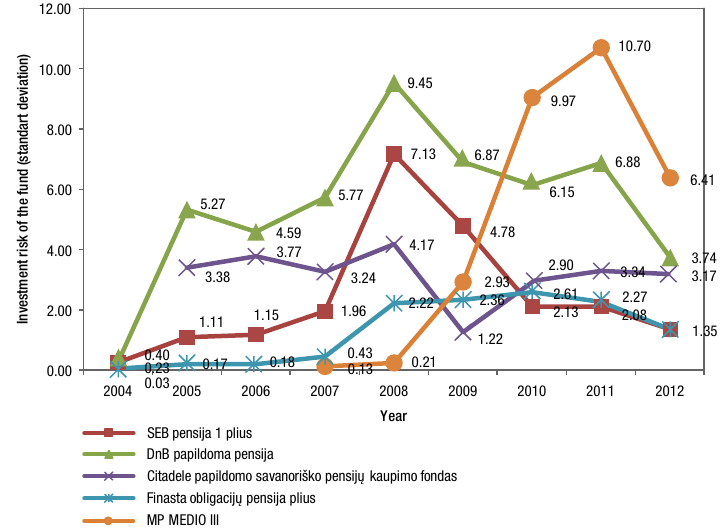
Fig. 5. Change of bond and balanced 3 rd pillar PF standard deviation during 2004–2012 Source : created by authors according to annual reports of